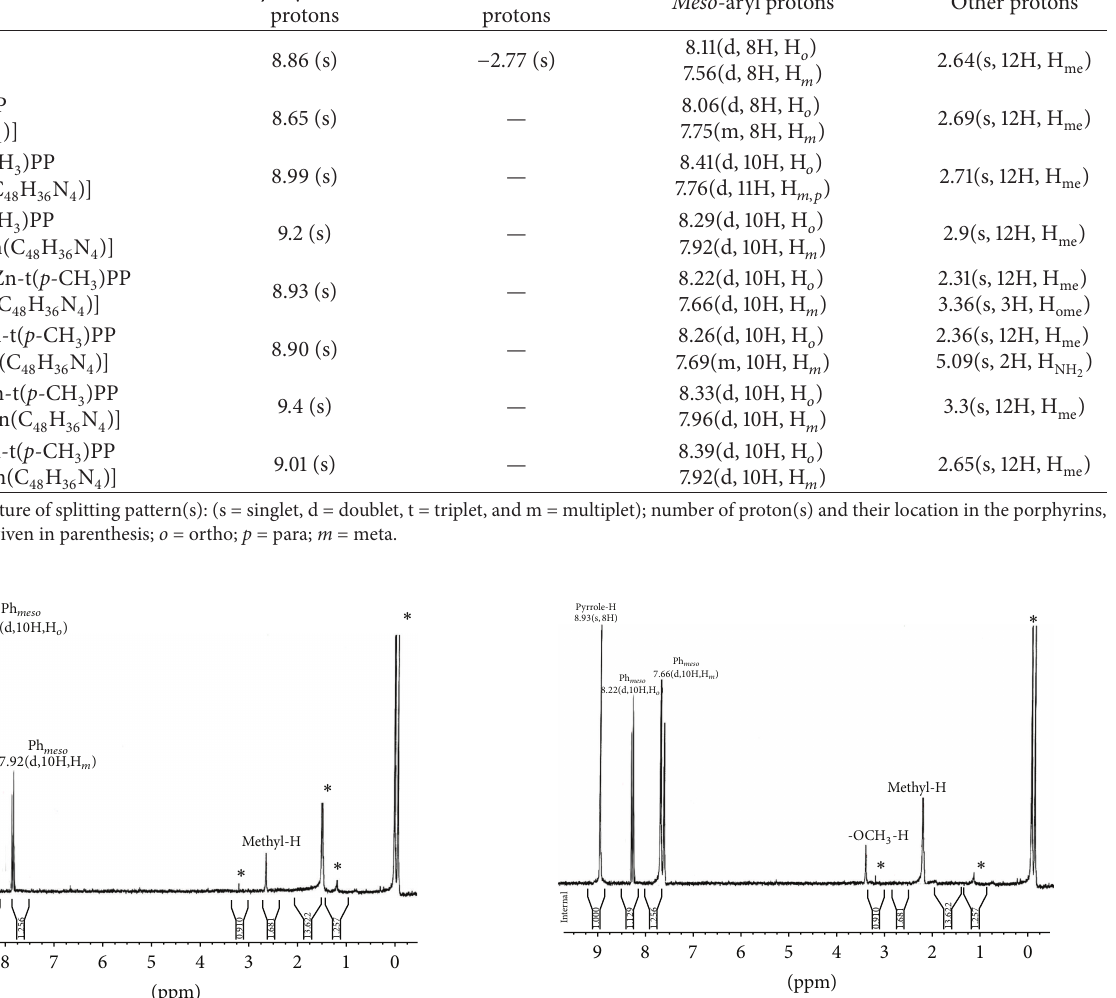
Table 1: 1 H NMR data a of free base H 298 K.